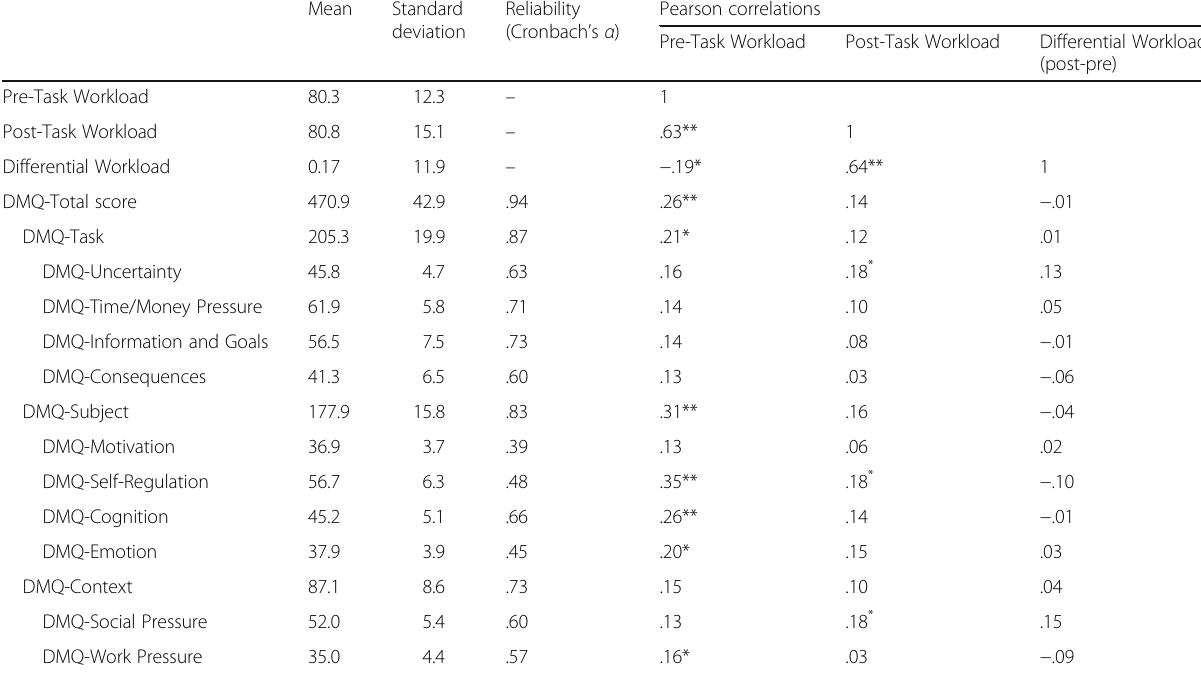
Table 2 Descriptive statistics, reliability, and linear correlation indexes between the variables of the study and the indicators of